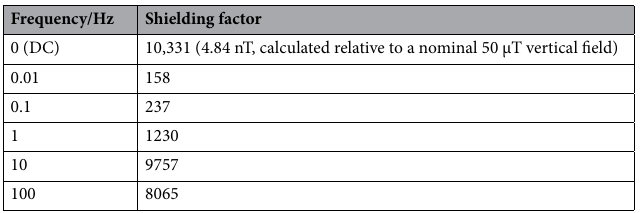
Table 1. Shielding factors of the MSR at different frequencies measured with a fluxgate magnetometer.